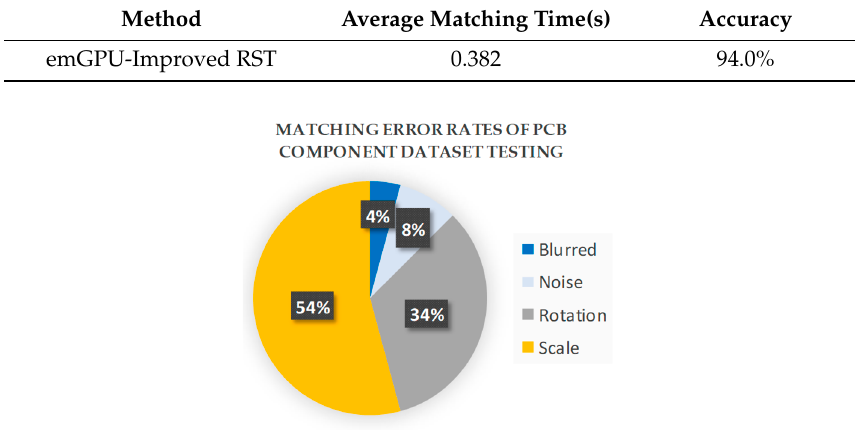
Figure 8. Matching error rates of the different test image types in the PCB component dataset.